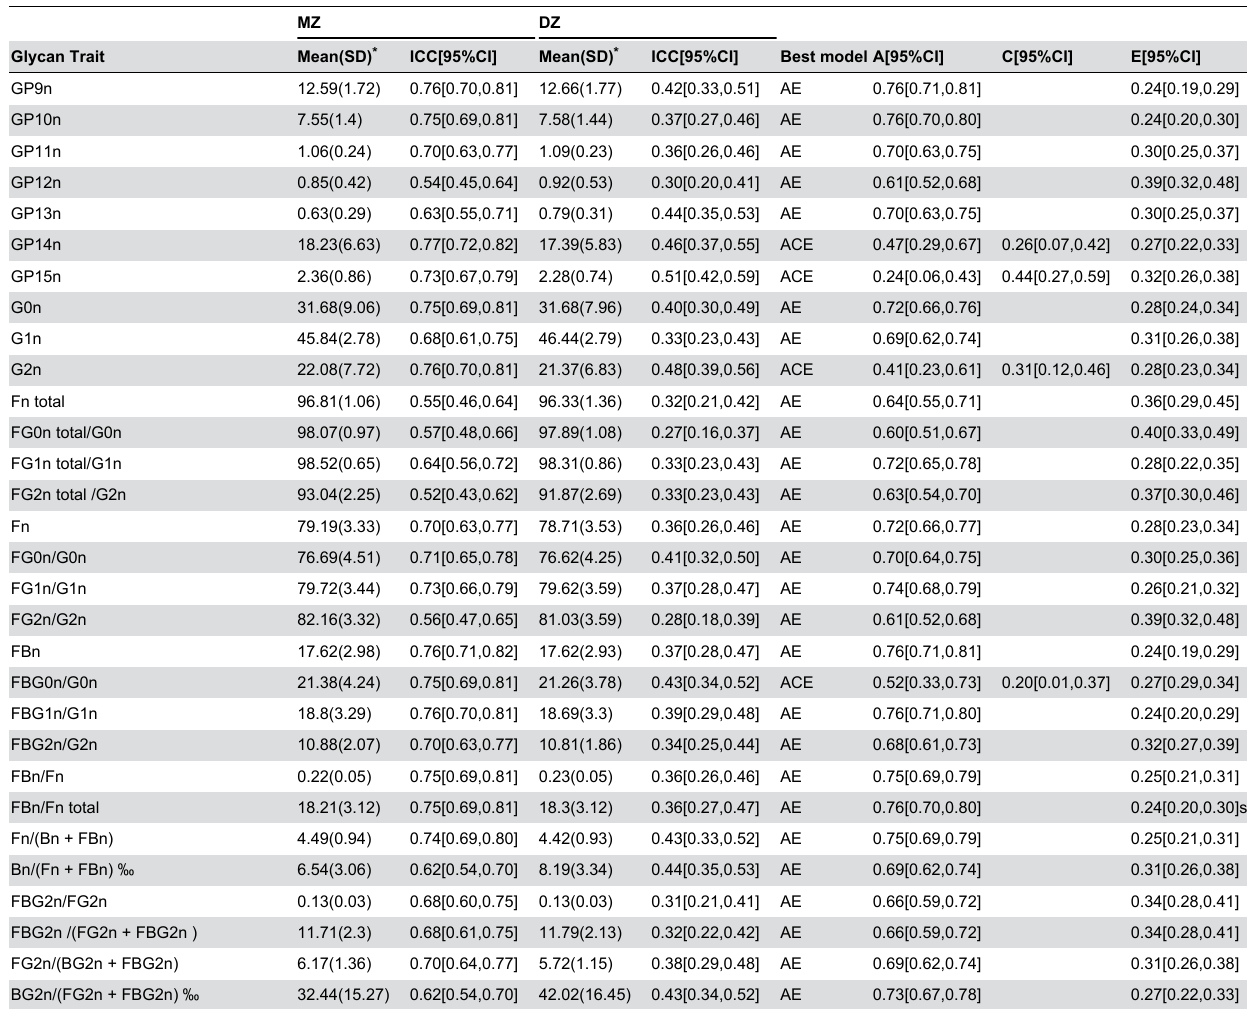
Values in the three rightmost columns indicate the amount of variance attributed to the compartment of additive genetic factors (A or heritability), common/shared environmental factors (C) and unique environmental factors (E). ICC = intra-class correlation coefficient. 95% confidence intervals for both ICC and ACE are reported. * means and SD reported are unadjusted